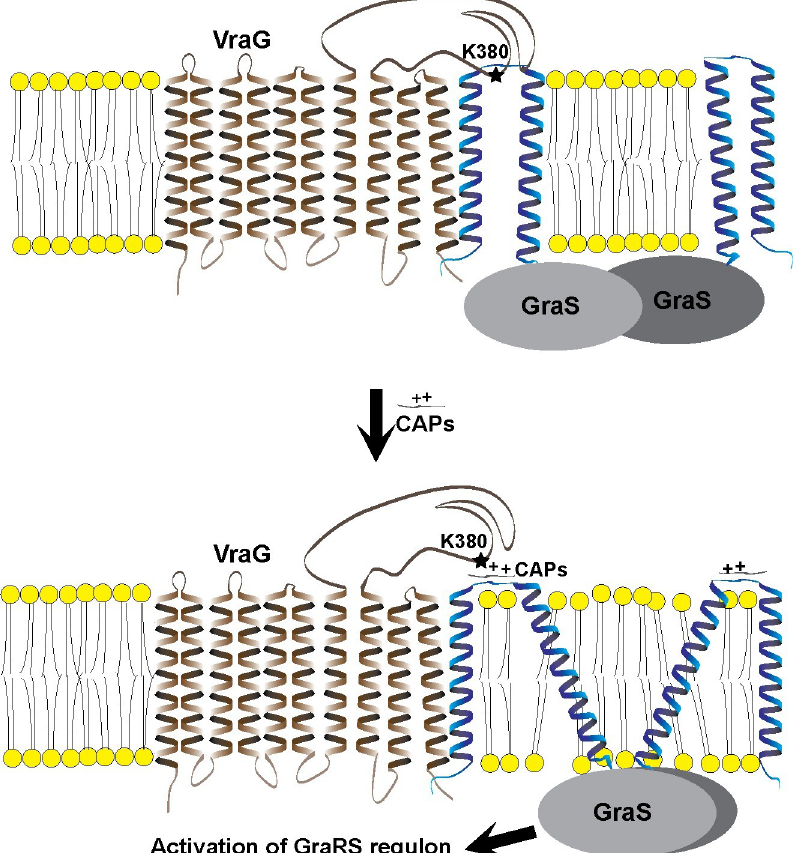
Fig 8. A model of the EL of VraG in modulating HDP-mediated signaling by GraS. The K380 of VraG interacts with the loop of GraS. This tight interaction is loosened by the binding of HDPs to the EL of GraS. The dimerization of GraS would occur under the unlatched condition of GraS in the absence of interference from the EL of VraG, resulting in activation of GraS.